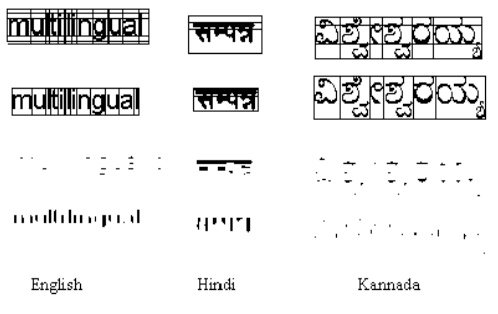
Figure 7. Sample output images of English, Hindi and Kannada text words.